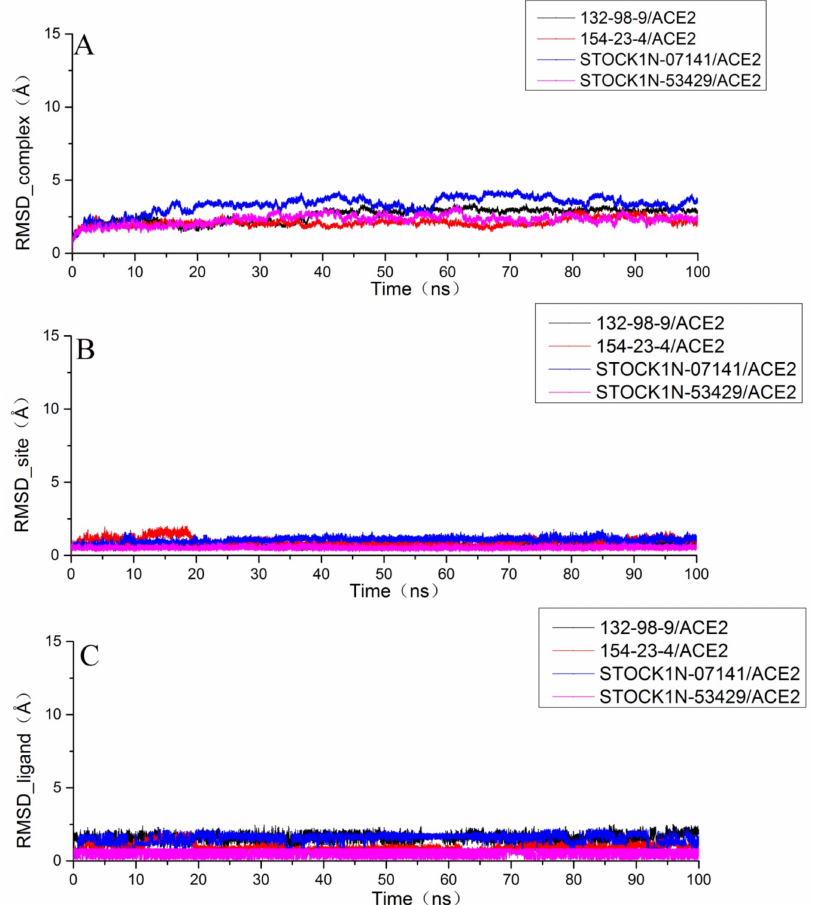
Figure 4. Root mean square deviation (RMSD) of each system. ( A ) The RMSD of the protein backbone atoms of the complex; ( B ) the RMSD of the heavy atoms (all non-hydrogen atoms) of the ligand; and ( C ) the RMSD of the C α atoms at the binding site with residues within 5 Å around the